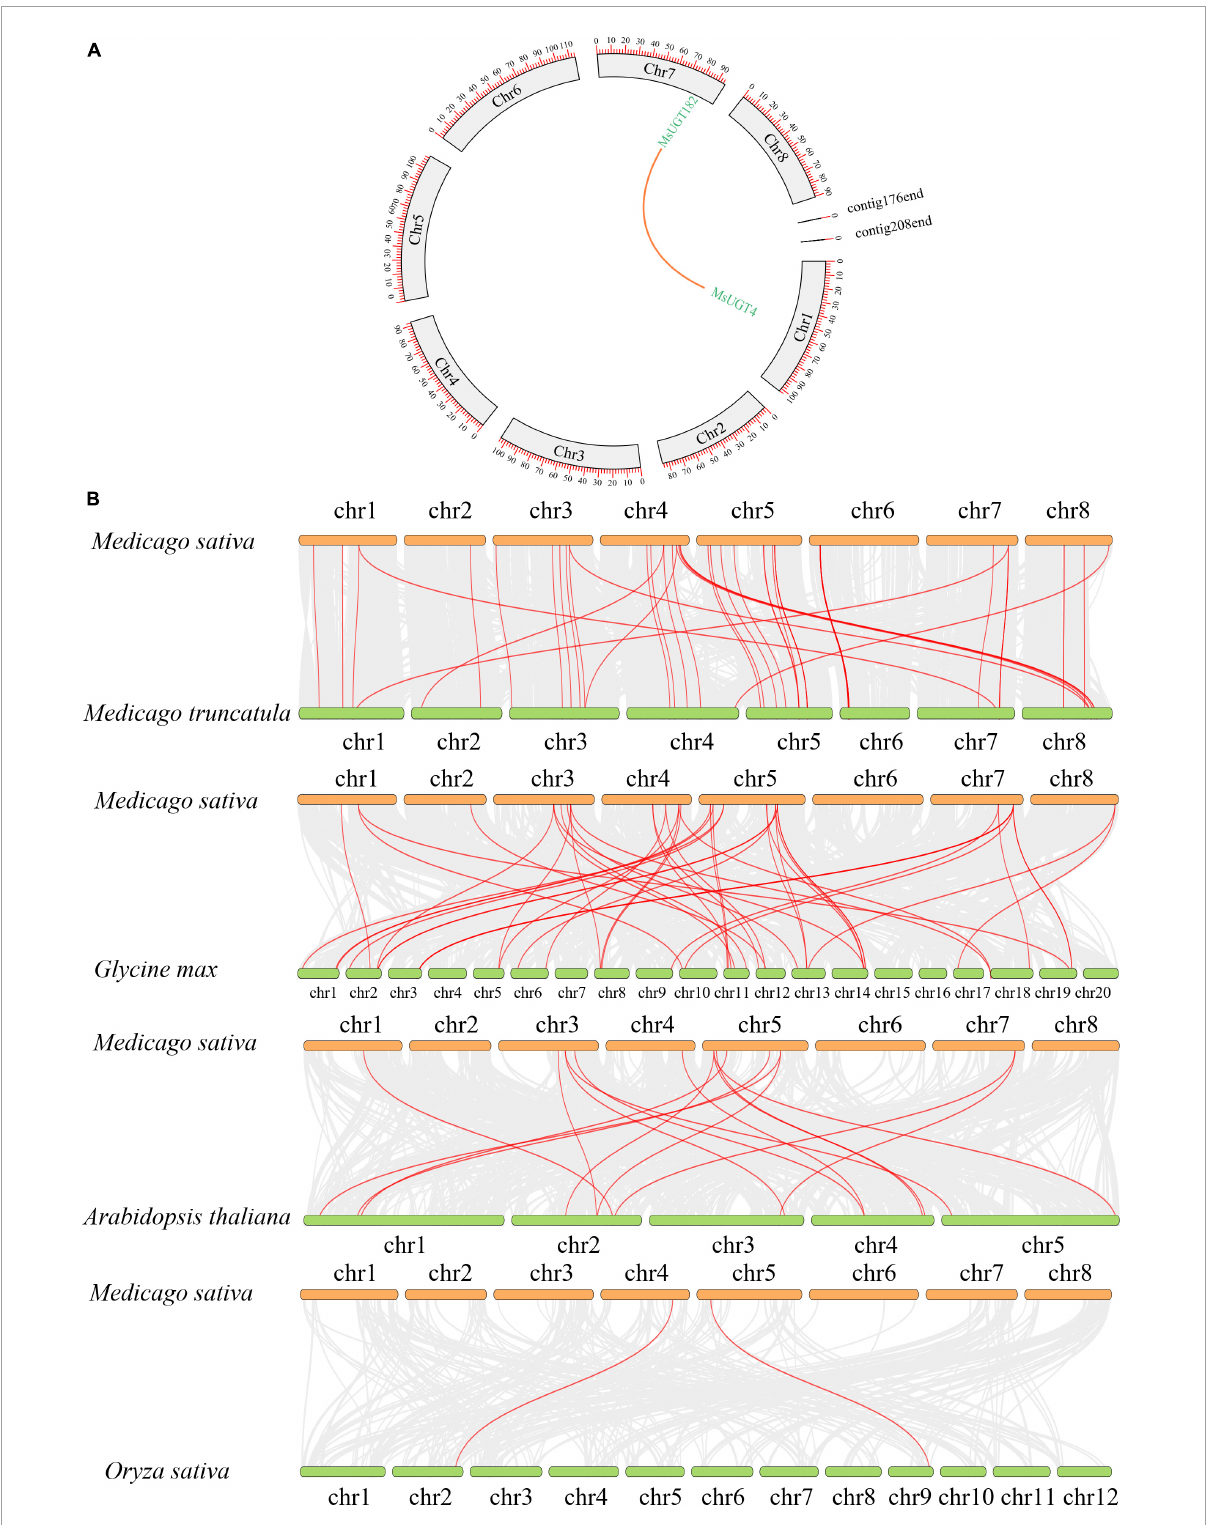
FIGURE6 MsUGT gene duplications in the genomes between and within species. (A) The duplicated event is a collinearity block in the alfalfa genome, and the segmental duplication between MsUGT4 and MsUGT182 is drawn with an orange line. (B) The collinear blocks of UGT genes between M. sativa and M. truncatula , Glycine max , Arabidopsis thaliana, and Oryza sativa, respectively, are indicated by red